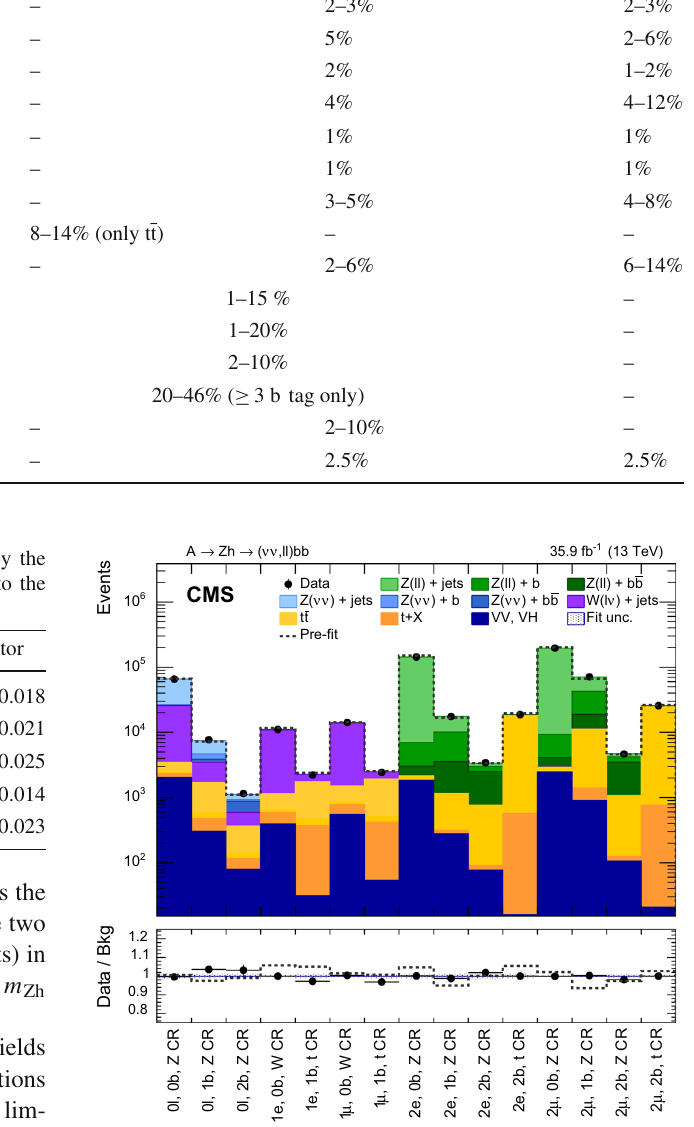
Fig. 3 Pre- (dashed gray lines) and post-fit (stacked histograms) num- bers of events in the different control regions used in the fit. The label in each bin summarizes the control region definition, the selection on the number and flavor of the leptons, and the number of b-tagged jets. The bottompaneldepictstheratiobetweenthedataandtheSMbackgrounds